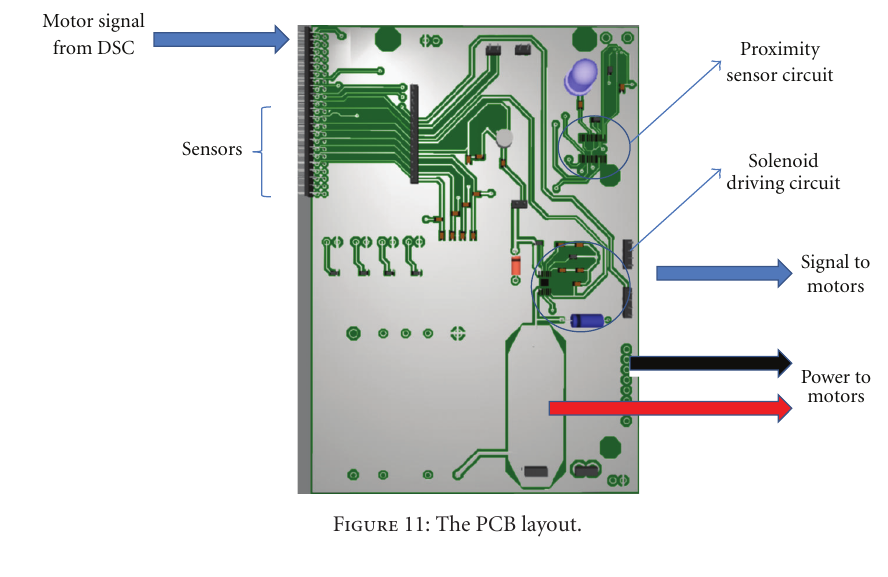
byte serial commands. The driver outputs a pulse width modulated signal at 32